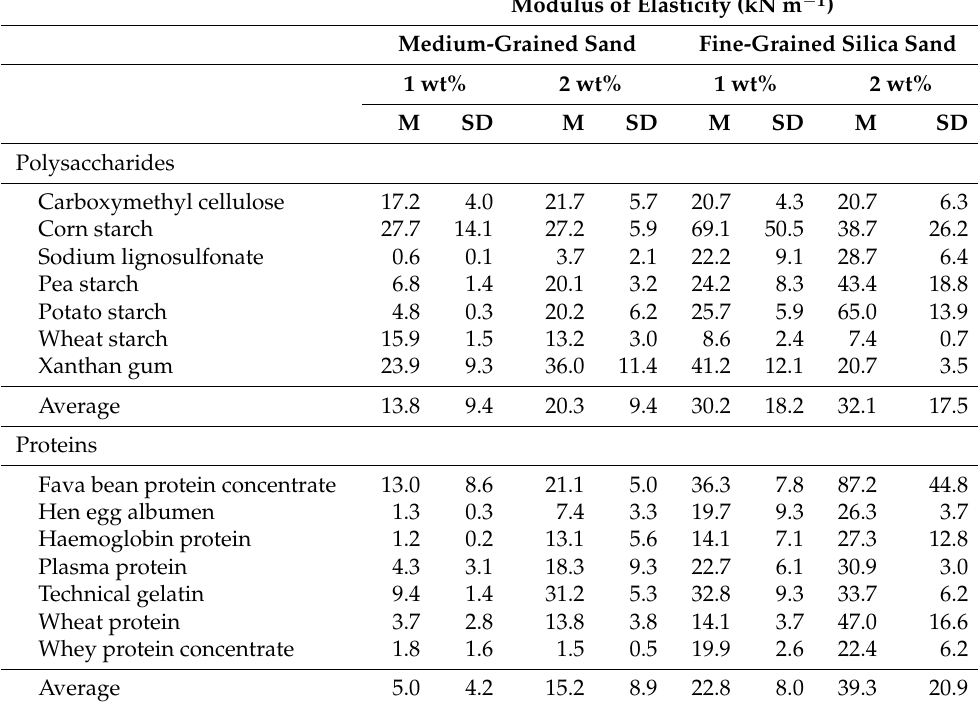
Table A4. Mean modulus of elasticity (M e ) of crusts formed on medium-grained and fine-grained silica sand samples treated at biopolymer concentrations of 1 and 2 wt% (XG = 0.25 and 0.50 wt%). Tests were performed in triplicates ( n = 3), with M = mean and SD = standard deviation. The water-treated control group formed no crust, so no M e could be